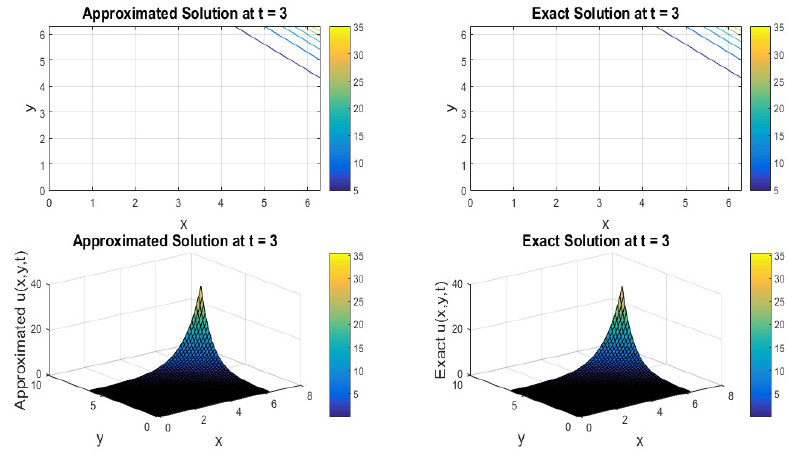
Figure 8. Comparison of approx. and exact profiles at t = 3 regarding Example 6.